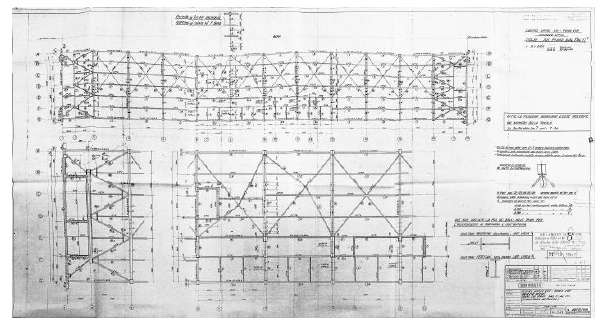
Figure 3: a carpentry plan of the ENI Office Building in Rome (courtesy of ENI’s Archive)